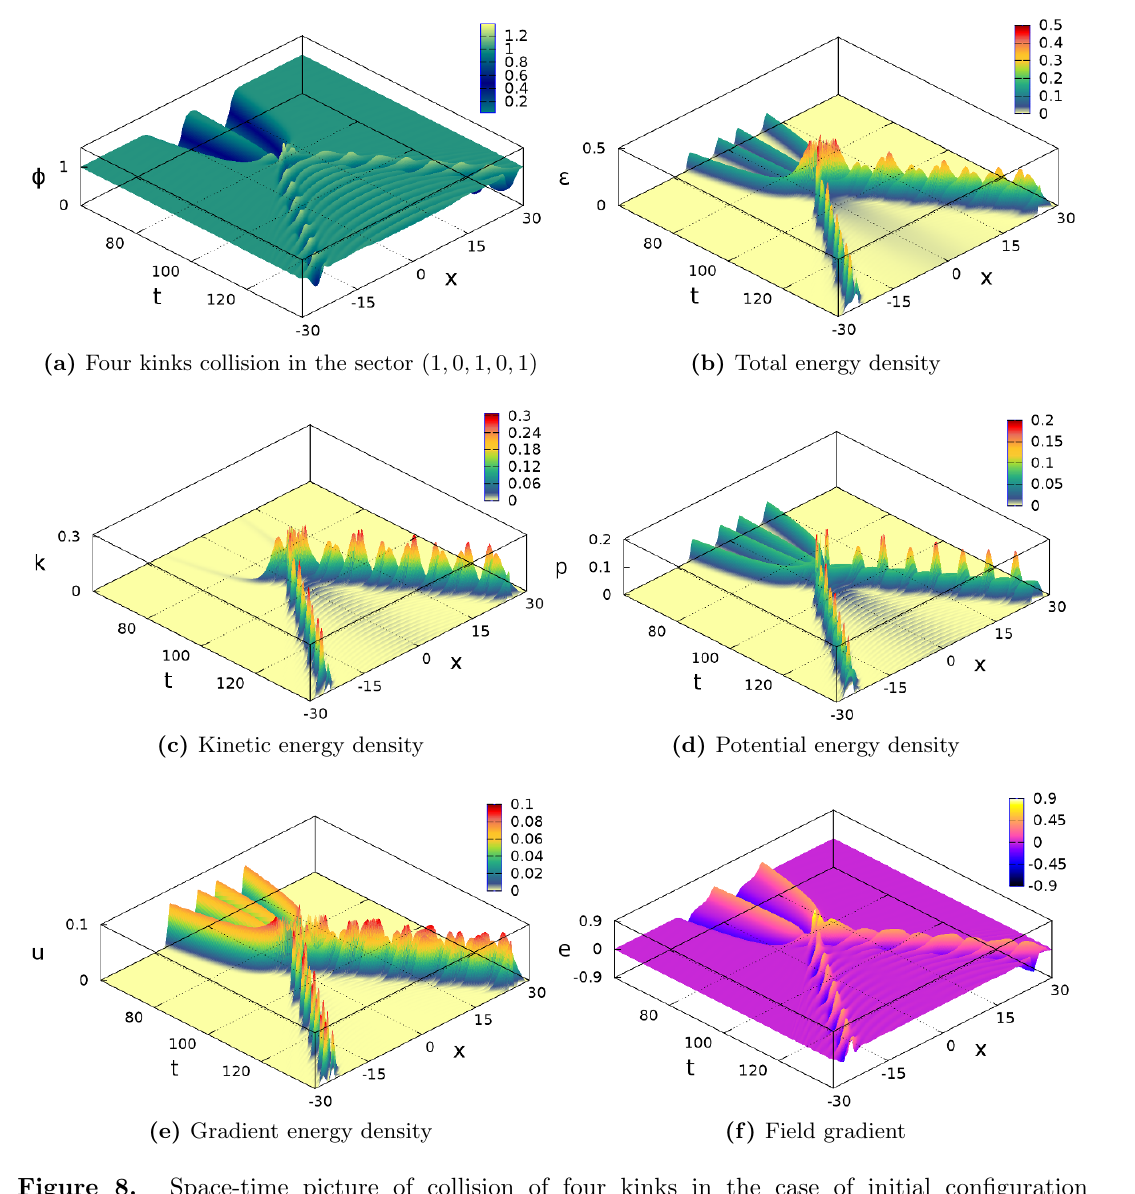
Figure 8. Space-time picture of collision of four kinks in the case of initial con(cid:12)guration (1 ; 0 ; 1 ; 0 ;